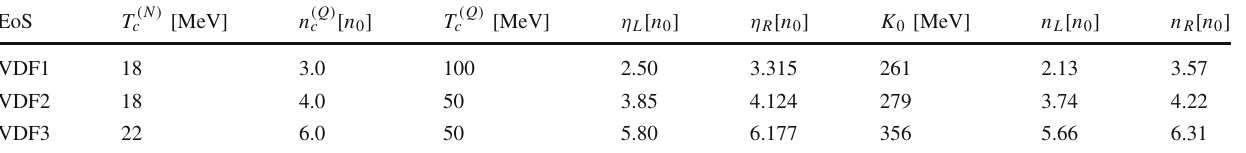
Table 1 Characteristics of the VDF EoSs used in this work. For all VDF EoSs, the saturation density, the binding energy, and the criti- cal density of the nuclear liquid-gas phase transition have been set at n 0 = 0 . 160 fm − 3 , E 0 = − 16 . 3 MeV, and n ( N ) c = 0 . 375 n 0 , respec- tively. The incompressibility K 0 and the boundaries of the coexistence region of the “QGP-like” phase transition at T = 0, denoted with